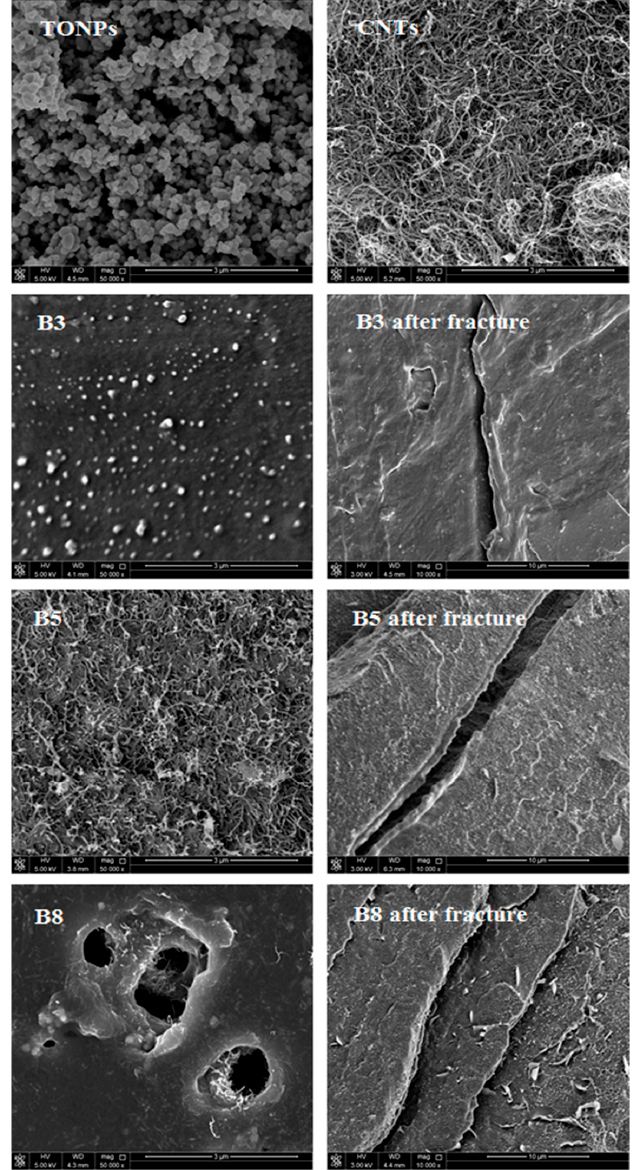
Figure 3. N-SEM images of titanium oxide nanoparticle (TONP) powder, CNTs, and the representative